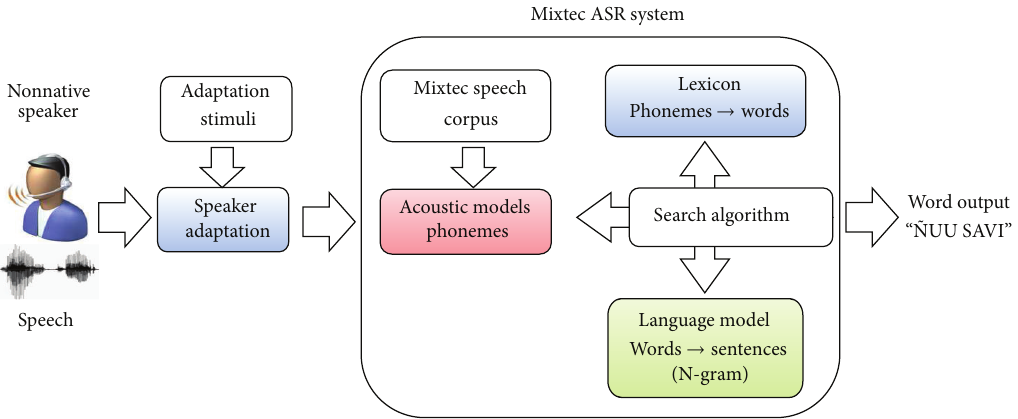
Figure 6: Elements of the speaker-adaptive Mixtec ASR system.